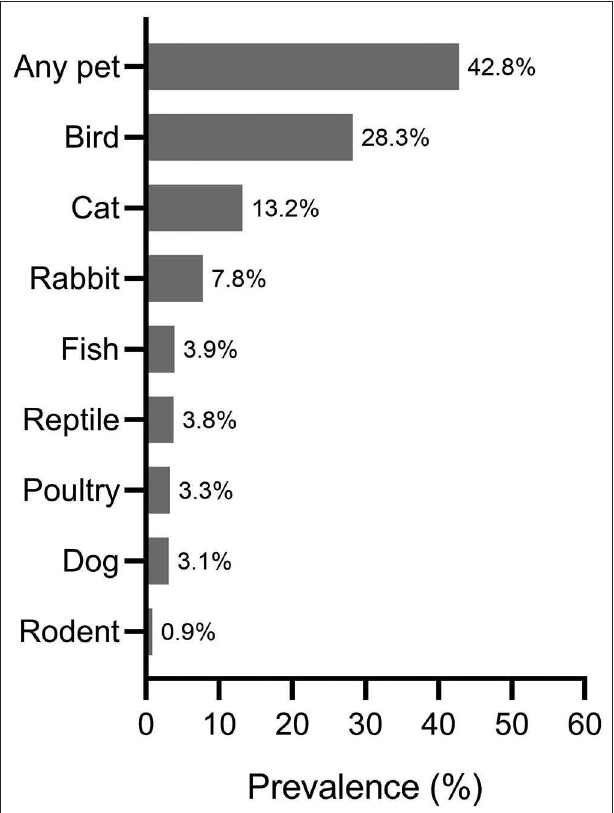
FIGURE 1 | Prevalence estimates of household pet-keeping in the past 12 months. Prevalence estimates are shown according to pet type. Also, prevalence estimate of having “any pet” is